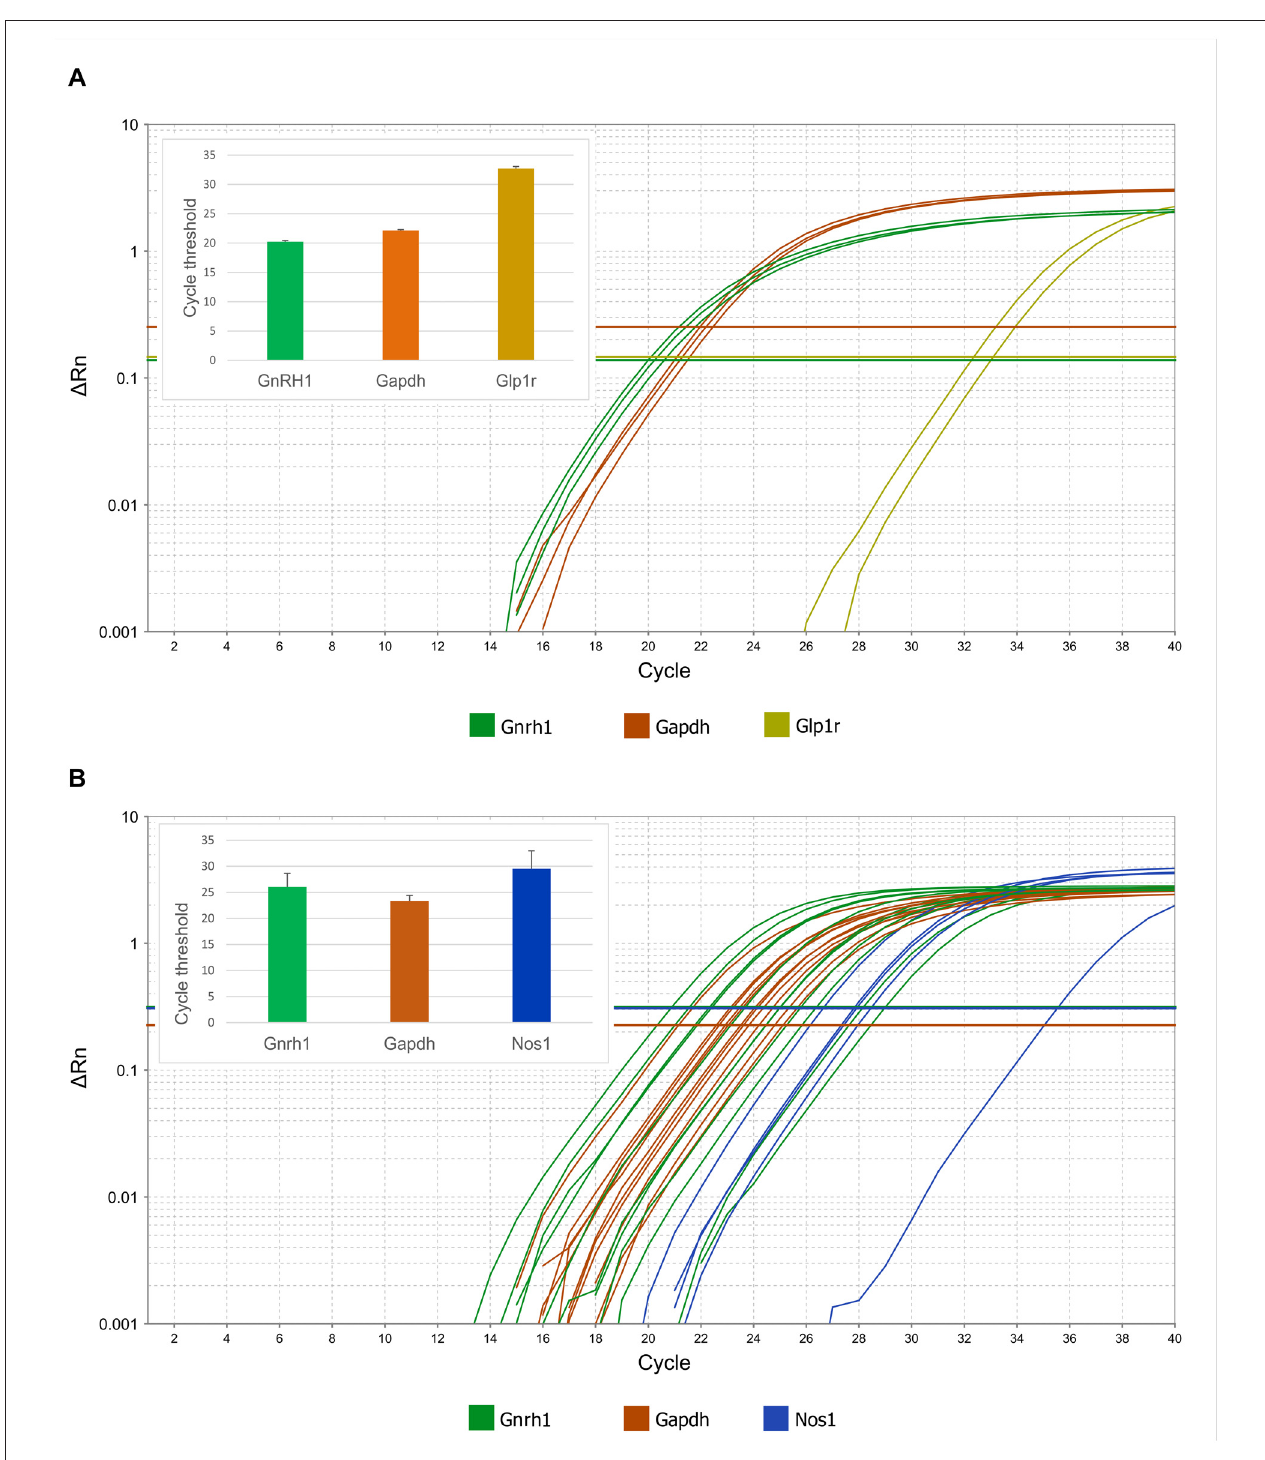
FIGURE 7 | Expression of Glp1r and Nos1 mRNAs in GnRH neurons harvested by patch electrodes for single-cell qPCR. Real-time qPCR amplification of Gnrh, Gapdh, Glp1r and Nos1 cDNA from GnRH neurons. (A) Expression of Glp1r transcript was detected in two of three pools of GnRH neuronal cytoplasmic samples. The abundance of the Glp1r was low, indicated by its relatively high Ct values (32.5 and 33.1) as compared to the housekeeping gene Gapdh (22.0–22.5). (B) Expression of the Nos1 gene in individually harvested Gfap-negative GnRH neuronal samples. The logarithmic scale of Rn and number of PCR cycles are indicated on the Y and X axes, respectively. The onset of the exponential phase (Ct) is indicated by horizontal lines for each target gene. Column charts are in the inserts to show quantitative results of the qPCR experiments.